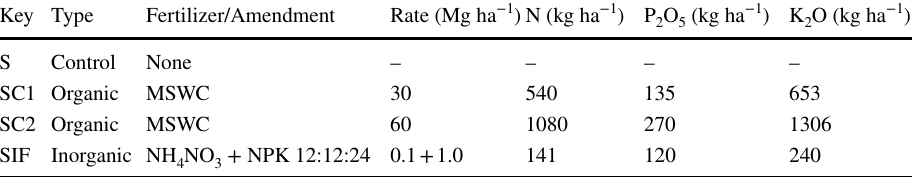
MSWC municipal solid